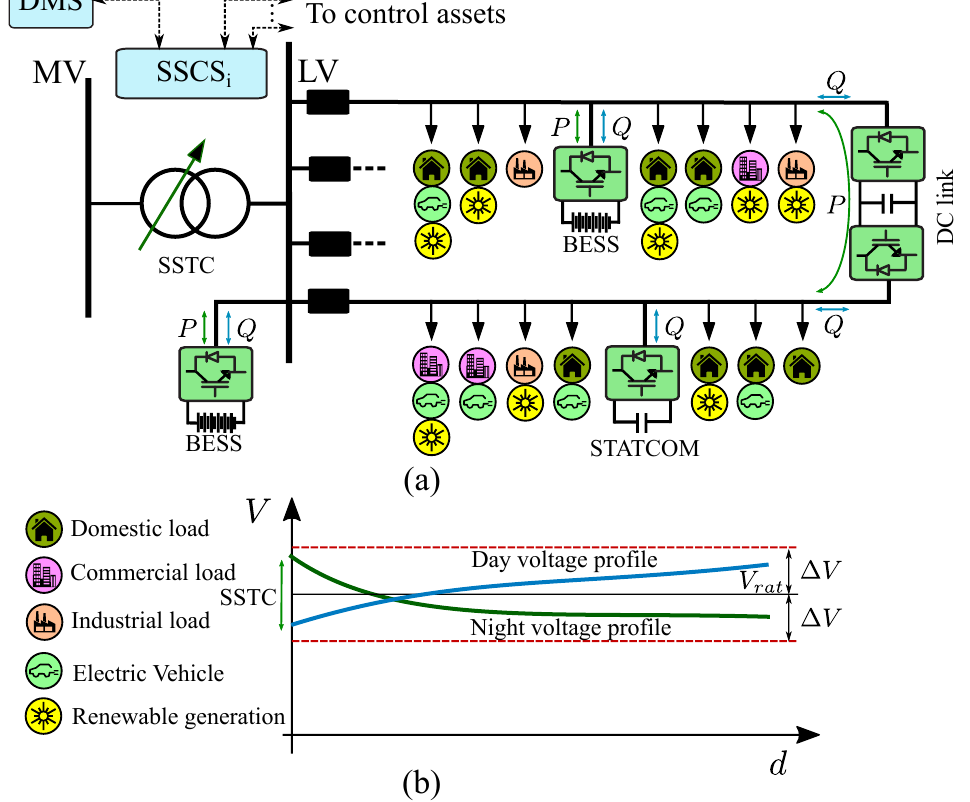
Figure 3. Advanced two-way LV distribution feeders: ( a ) one-line diagram; and ( b ) voltage profile along the